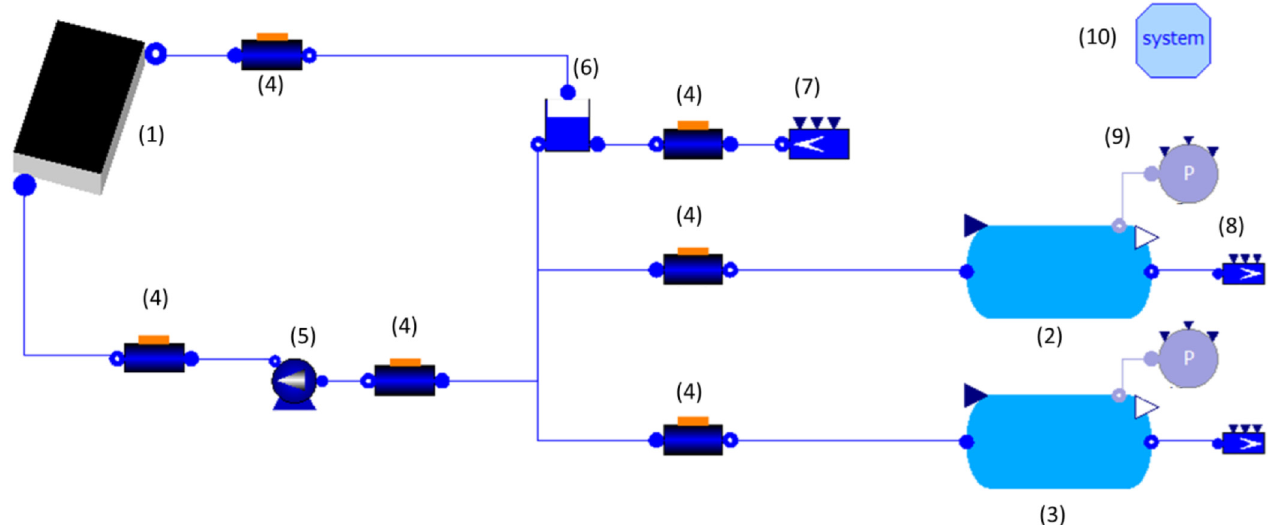
Fig. 2. Solar thermal energy system model built in OpenModelica: (1) Solar collector, (2) Boiler 1, (3) Boiler 2, (4) Pipes, (5) Pump, (6) Water storage tank, (7) Water Source, (8) Water Discharge, (9) Exhaust Gas Discharge, (10) System model.